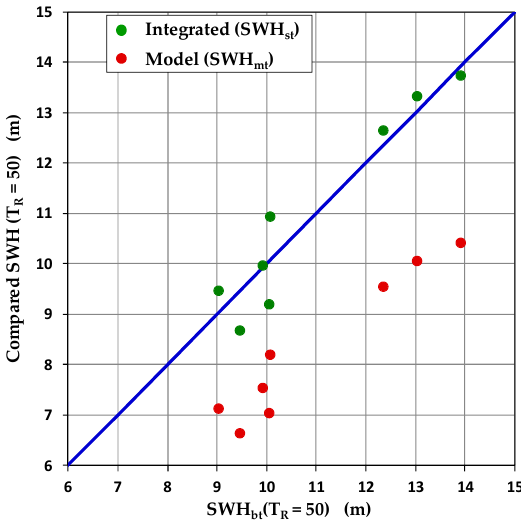
Figure 5. Atlantic Coast error analysis for T R = 50 years: SWH(T R ) values computed through model